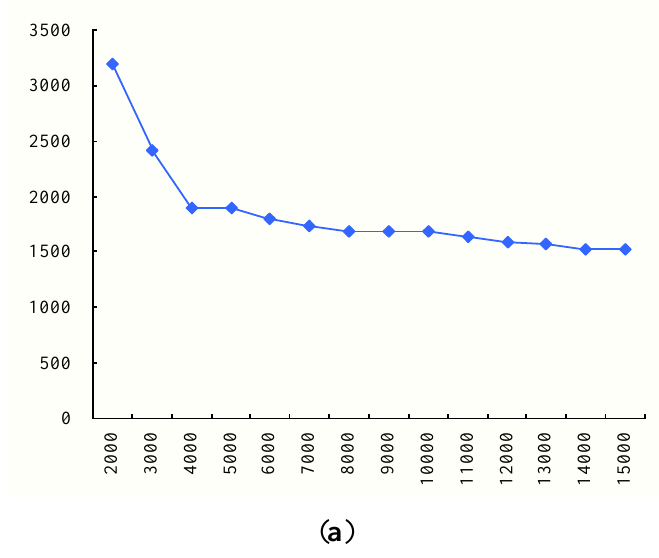
Figure 9. Results with four TDCs and different vehicle maximum capacities. ( a ) Total duration time; ( b ) Average arrival time; ( c ) Biggest traveling time; ( d ) The number of used